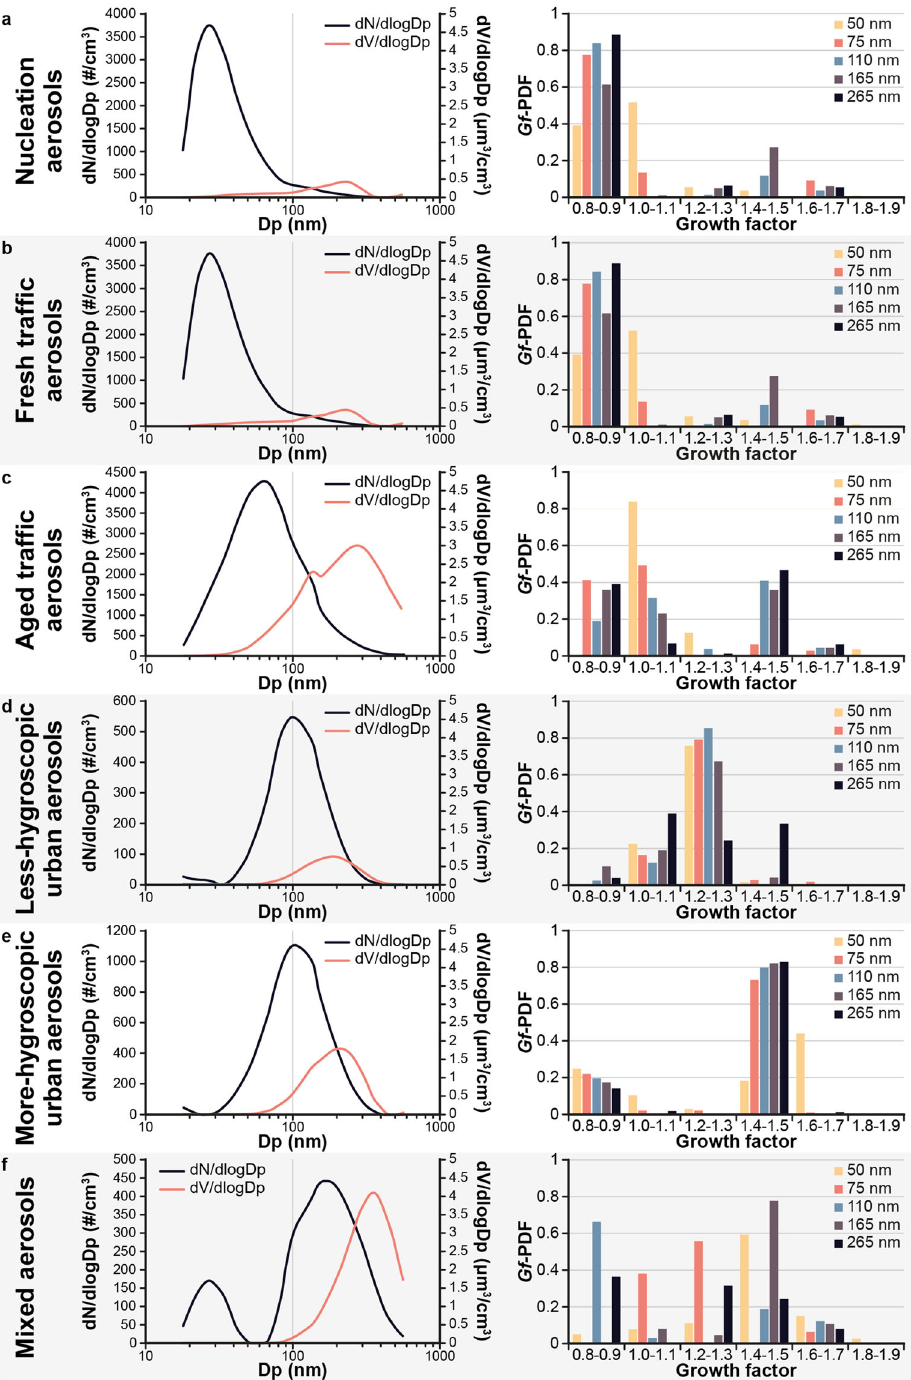
Fig. 5 Results of application of PMF to combined PNSD and hygroscopicity datasets. Source pro fi les of particle number size distribution and growth factor are shown for each PMF